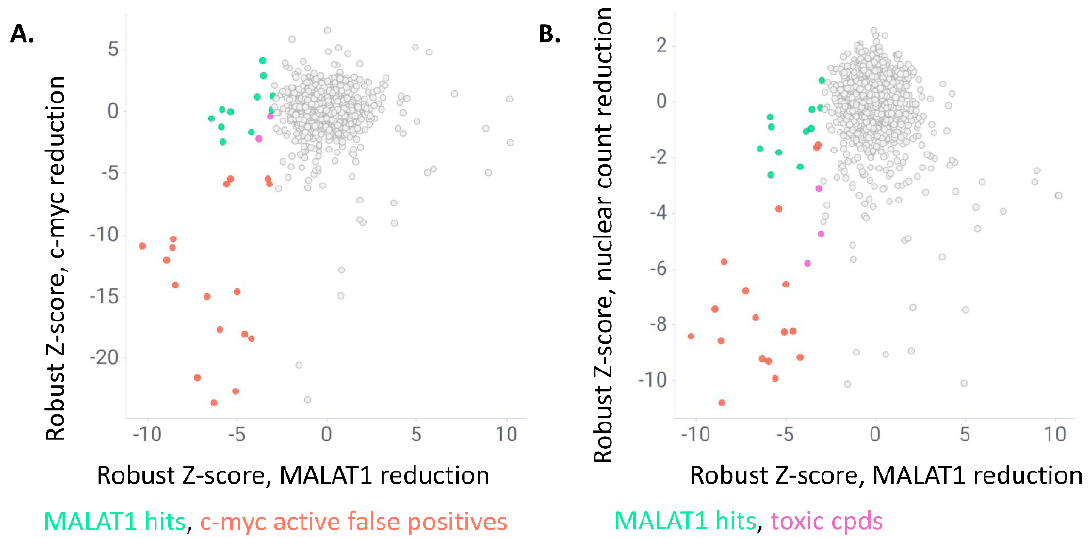
Figure 2. ( A ): Scatter blot showing robust Z-scores for MALAT1 nuclear staining intensity reduction on the x -axis and c-myc granule per cell count reduction on the y -axis. Compounds with a robust Z-score below − 3 for MALAT1 and above − 3 for c-myc are considered as hits (in green), compounds with robust Z-scores below − 3 for c-myc granule per cell reduction were considered as false positive hits (red). ( B ): Scatter blot showing robust Z-scores for MALAT1 nuclear staining intensity reduction on the x -axis and reduction in nuclear counts (i.e., number of viable cells) on the y -axis. Compounds with robust Z-scores below − 3 for nuclear counts were considered as toxic hits (purple).